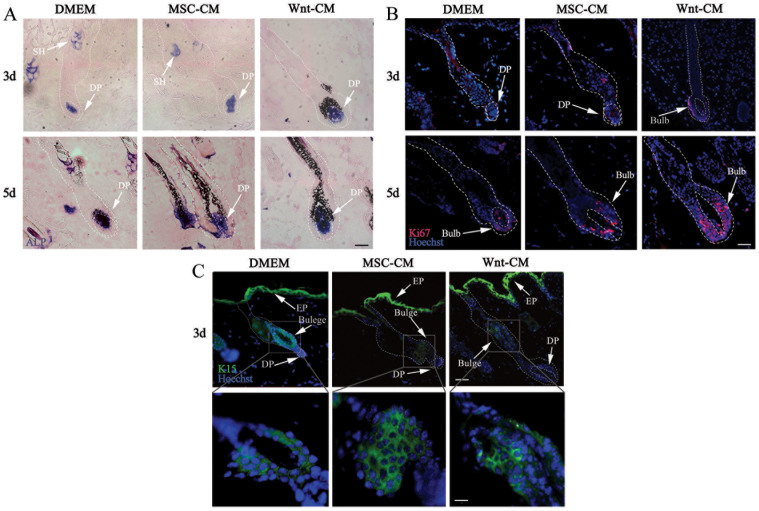
Expression patterns of structural markers in Wnt-CM-injected skin.(A) ALP activity was observed in the SG and DP at 3 and 5 days, Ki67 (B) at 3, 5days, and K15 (C) at 3 days. (D) shows a magnification of the framed labeled area. In each of the images, ALP (blue) is shown in blue, Hoechst (blue fluorescence), Ki67 (red fluorescence) and K15 (green fluorescence). The dashed line delineates the hair follicle structure. The arrowheads show the expression site of the DP (dermal papilla); SG, sebaceous gland; and EP, epidermis, scale bar (A–C) = 20 μm and (D) = 10 μm.